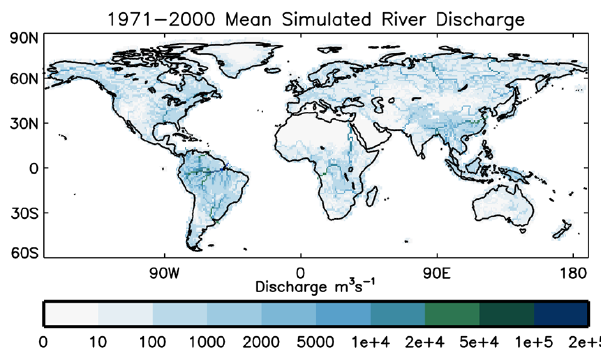
Figure 15. Mean river flow (m 3 s − 1 ) over 1971–2000 simulated by